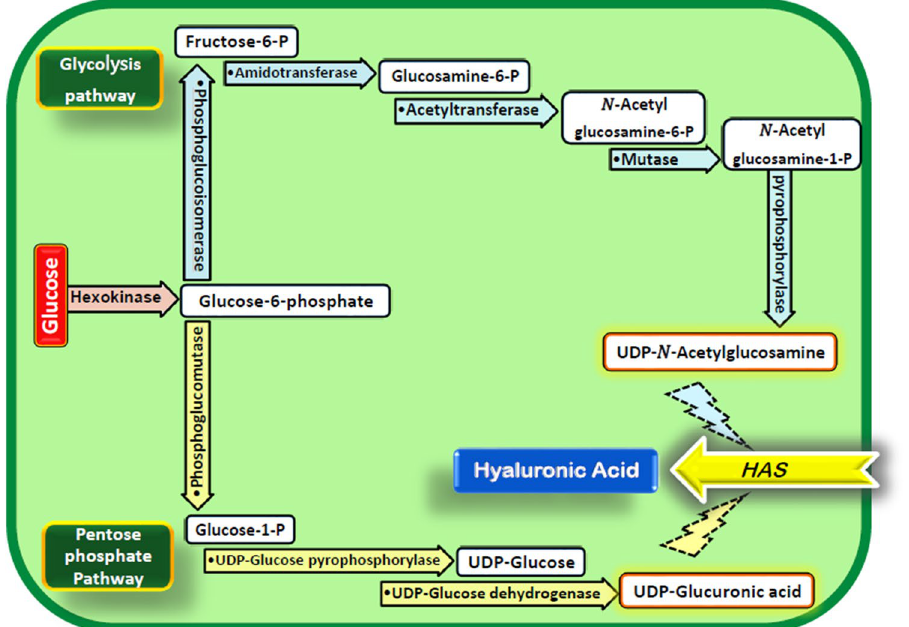
Figure 1. Schematic overview of the HA synthesis pathway in transgenic plants. HA precursors are produced in plants along the glycolysis and pentose phosphate pathways. By introducing only the HAS gene, plants are able to produce